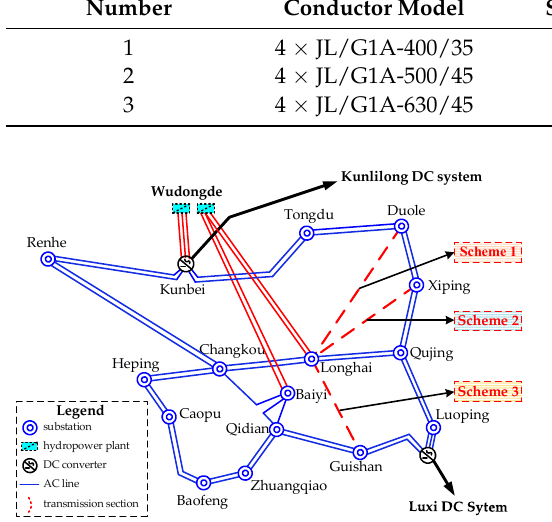
Figure 7. Sketch map of Scheme 1, Scheme 2, and Scheme 3. Table 7. Main parameters of optional conductors.